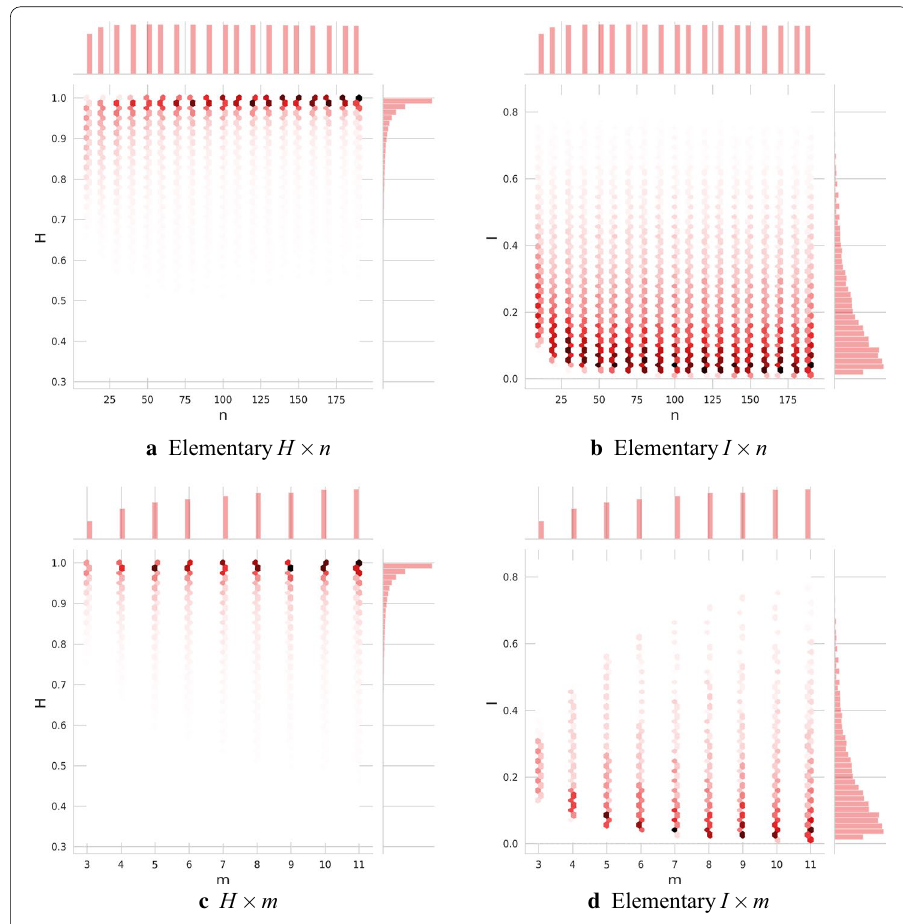
Fig. 8 Results on synthetic multiplex networks without considering transition coupling. Dependency on the number of nodes n ( a , b ) and layers m ( c , d ) on the elementary layer entanglement. The intensity ( b , d ) shows some influence on each